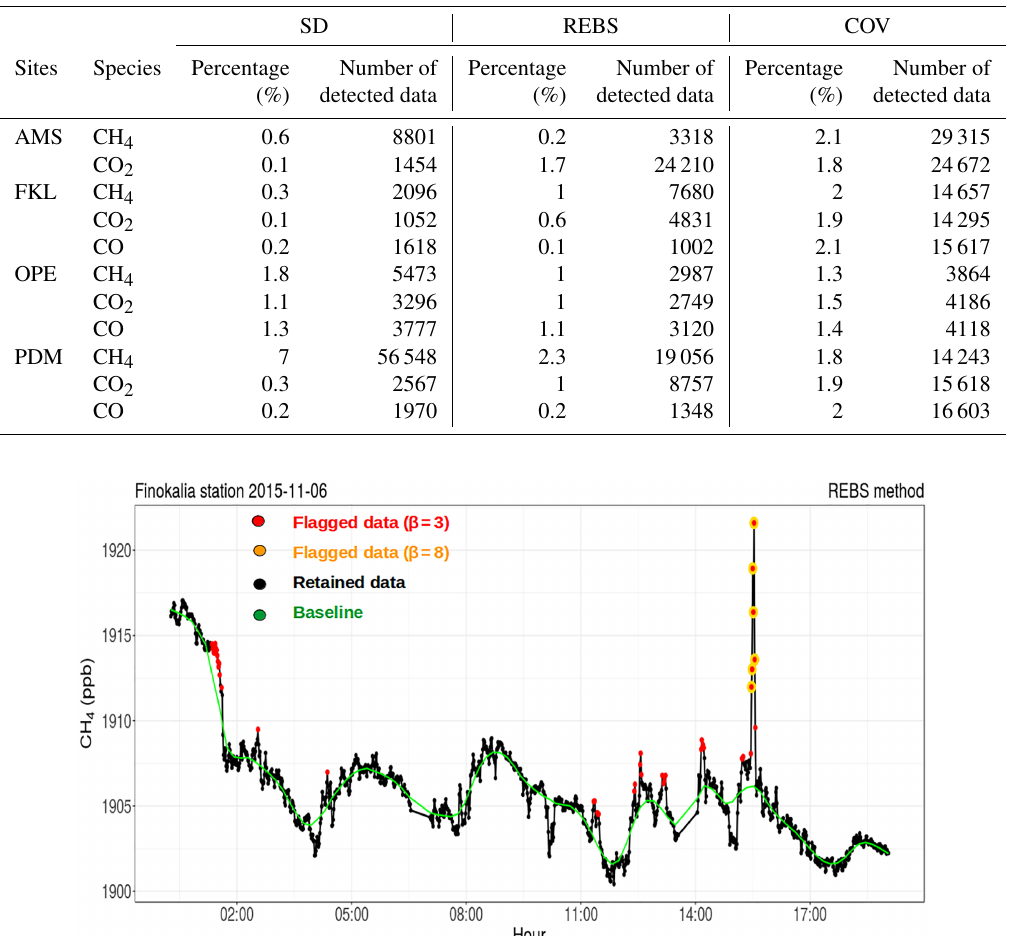
Figure 2. Comparison between two sets of ß parameter for REBS method. Red represents detected data for β = 3; orange is the detected data for β = 8, applied on FKL measurement 6 of November